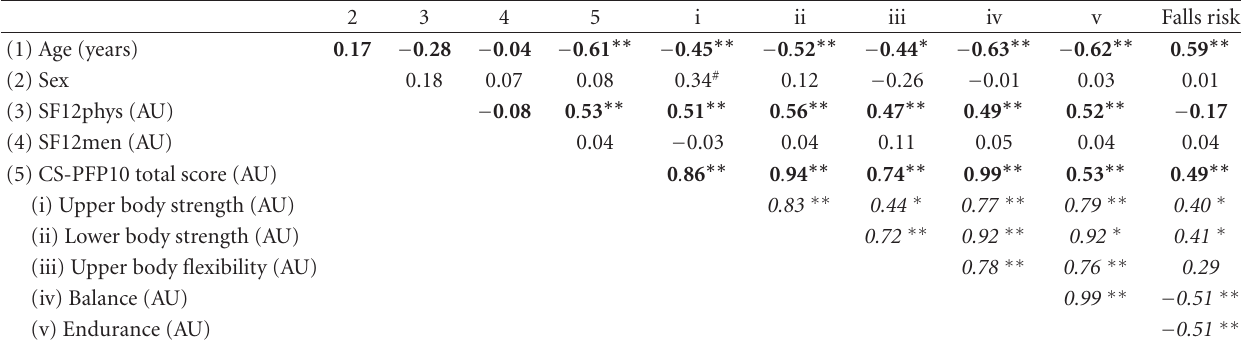
Table 2: Correlation analysis between, sex, age, falls risk, physical functional performance, and health for sample participants (aged 65–92 years) (italic data are the domain score physical functional